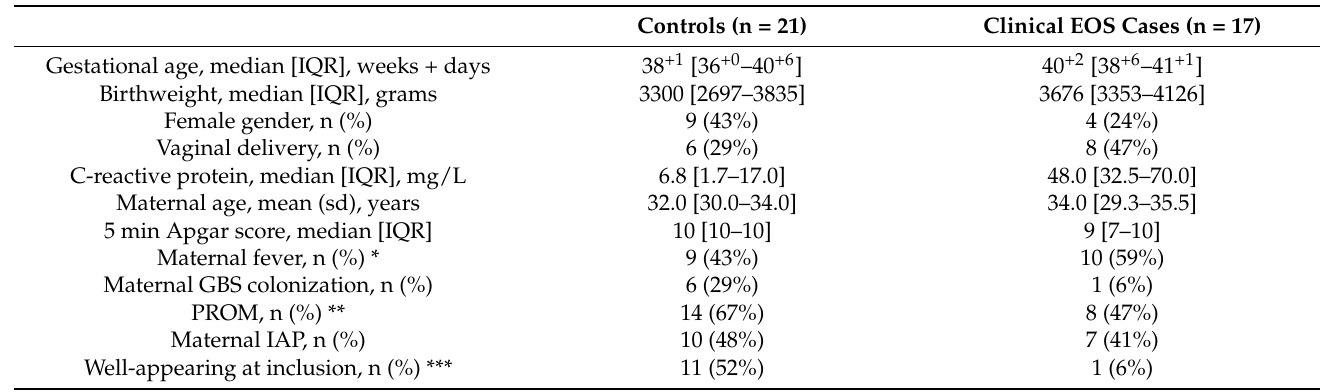
Table 2. Baseline